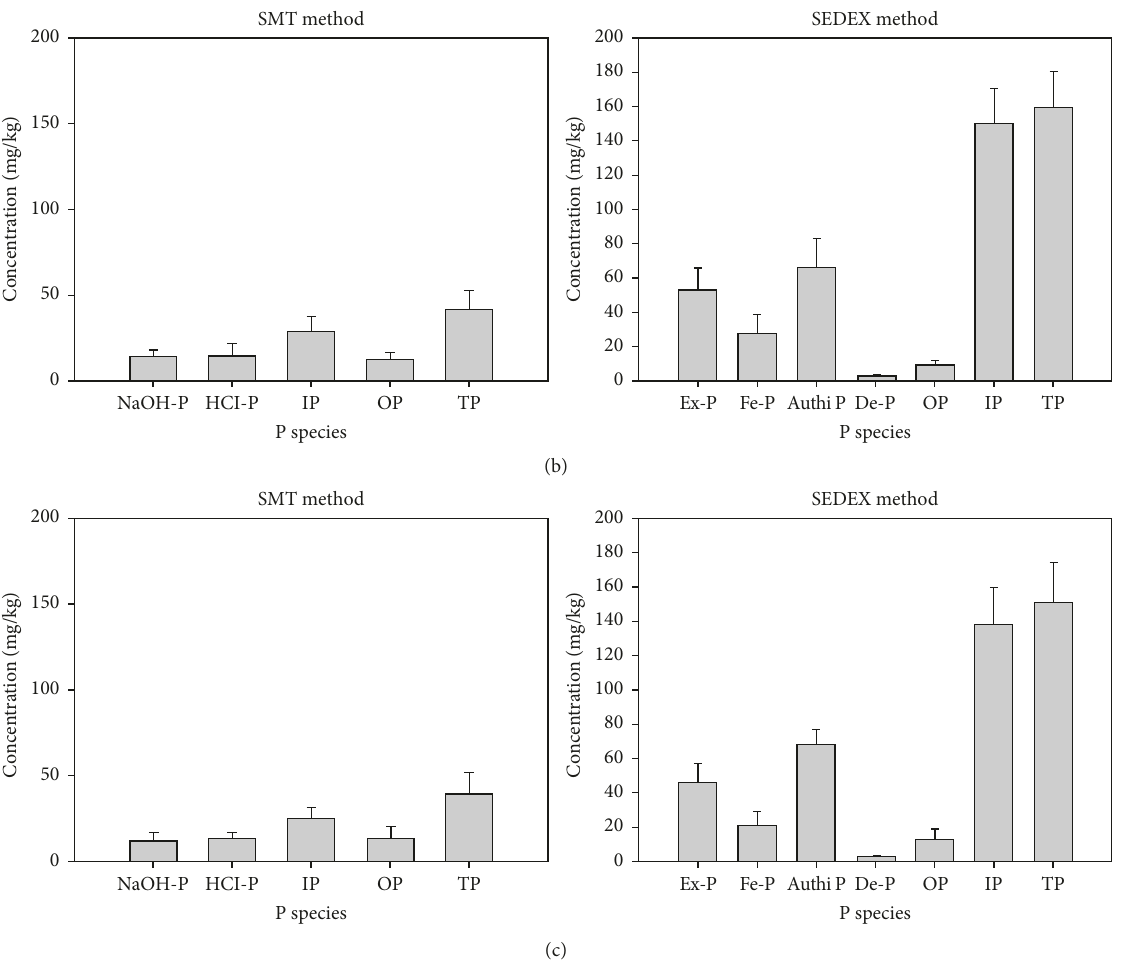
Figure 1: Comparison of sedimentary P species elucidated by the SMT and SEDEX methods for (a) AD-A, (b) AD-B, and (c)